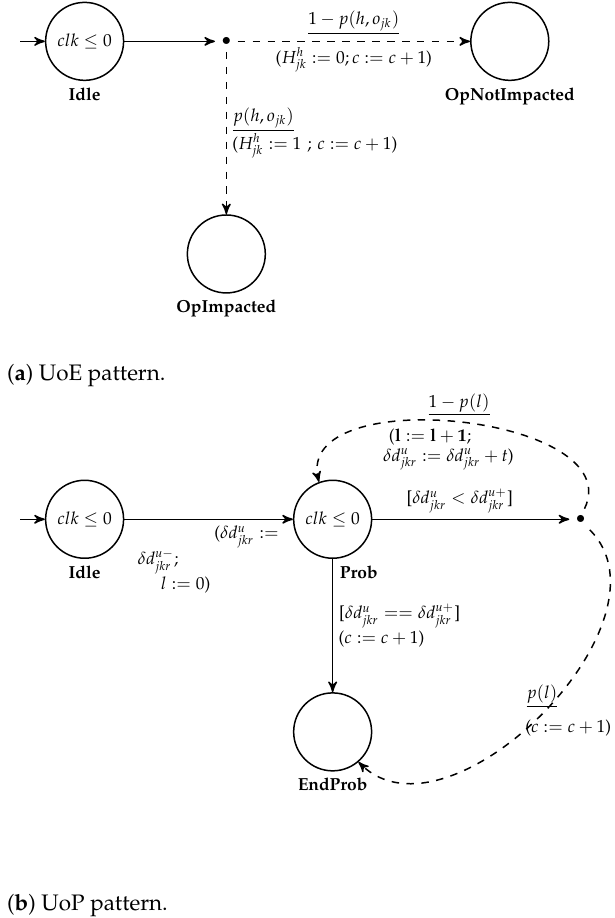
Figure 5. Stochastic patterns of